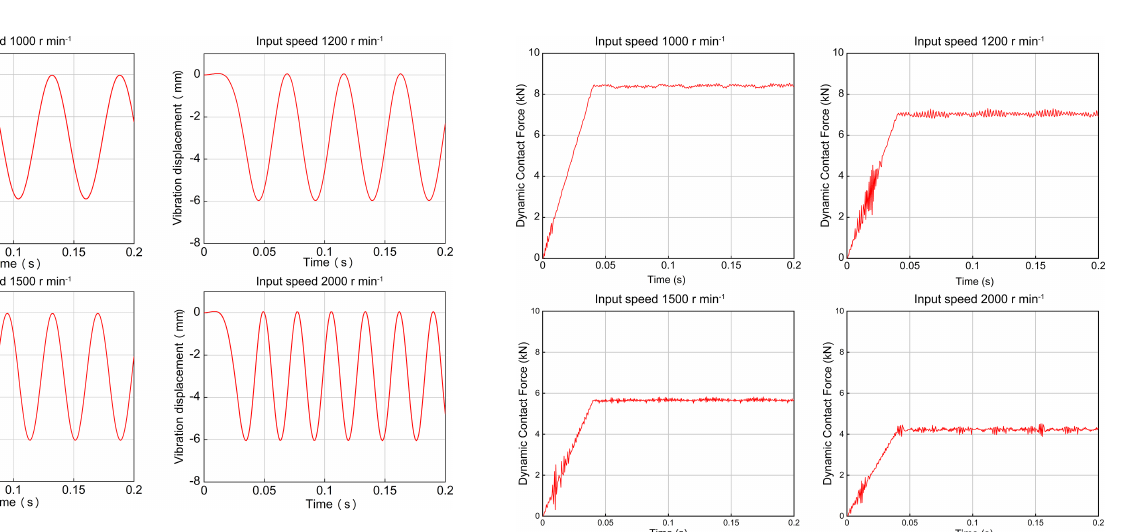
Figure 12. Vibration displacement under different input speeds.